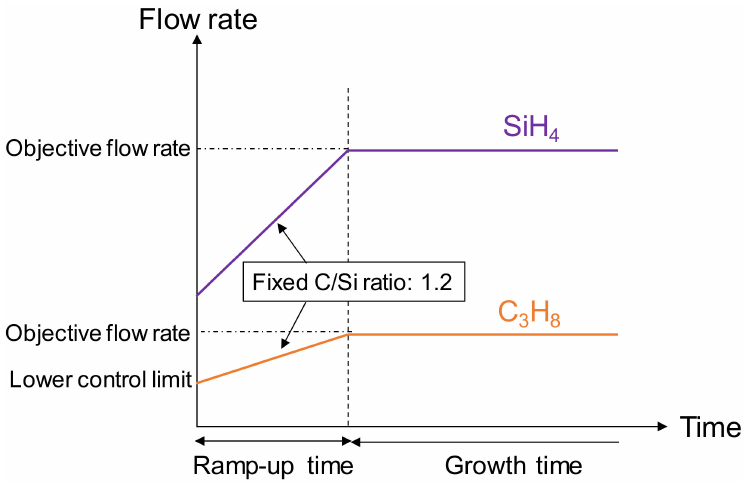
Figure 1. Growth process diagram of on-axis 4H-SiC epitaxial layers showing ramp-up time of the precursors flow rates.